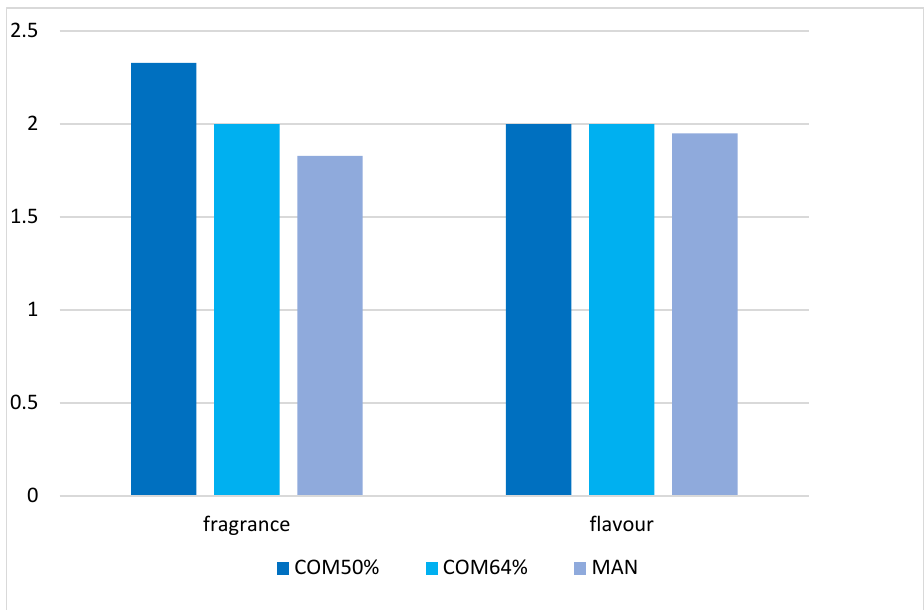
Figure 5. Evaluation of the taste of the samples, results of sensory analysis through the sequencing method. MAN–raw chocolate, COM 64%–classic bitter chocolate 64%, COM 50%–light bitter chocolate 50% (COM 50%).